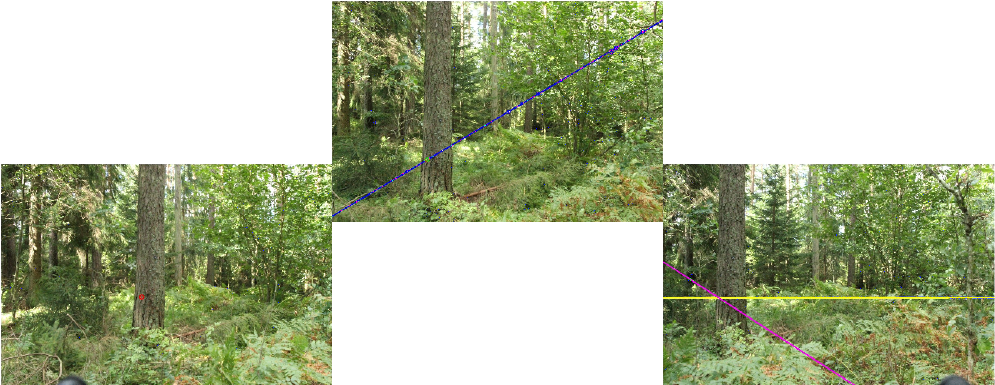
Figure 3. An example view from Cameras 1, 3 and 5; epipolar lines in Camera 3 and 5 for the marked ( red ) feature point in Camera 1.